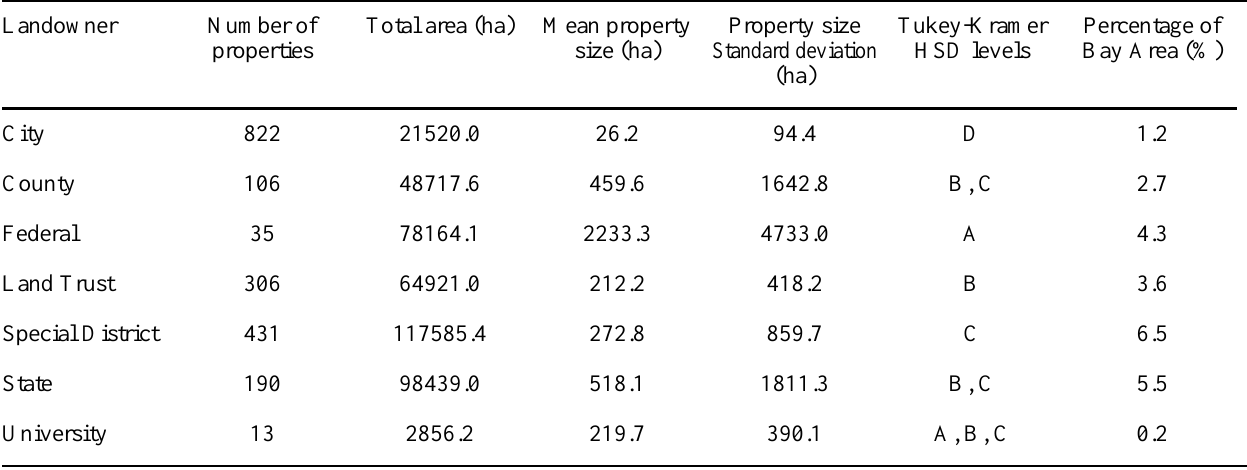
Table 2 . Number and size of protected areas held by each type of landowner in the nine-county San Francisco Bay Area. The Tukey-Kramer honestly significant differences (HSD) test indicates that landowners not connected by the same letter (A–D) have significantly different mean property